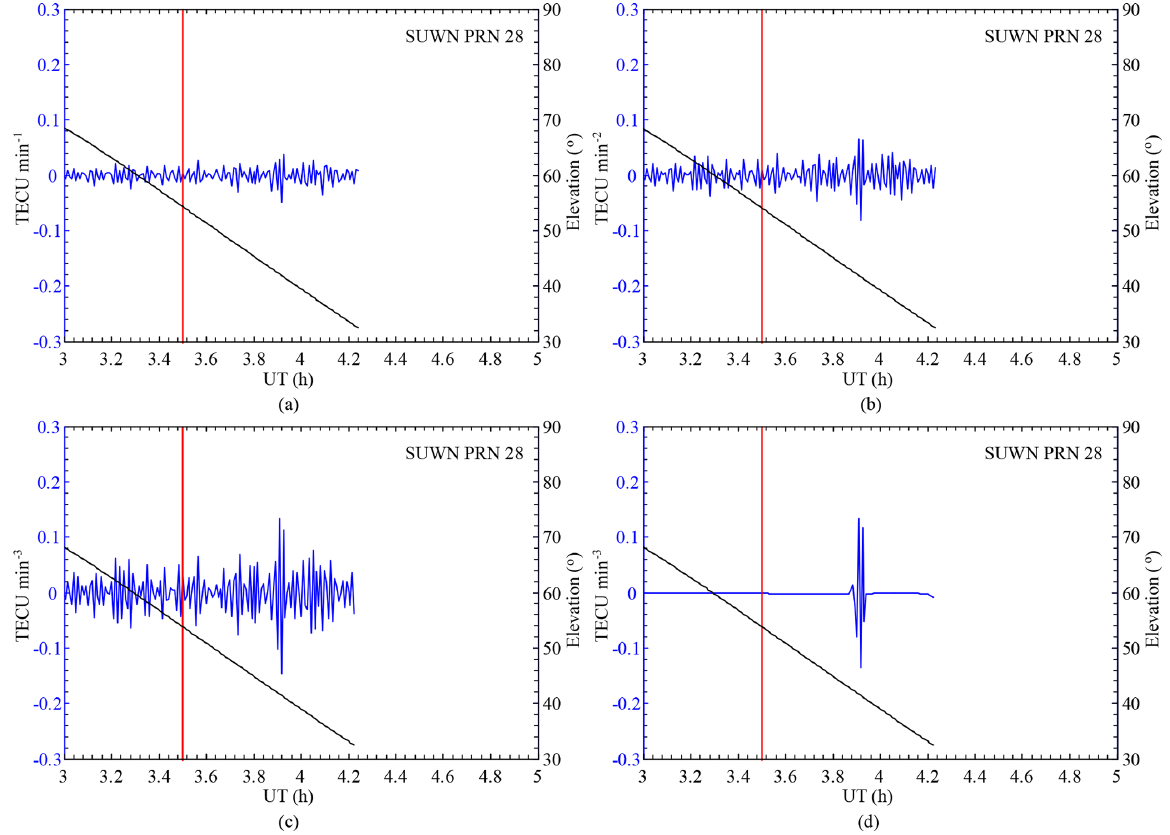
Figure 3. The time sequences of derivatives of relative STEC obtained by the SUWN station using satellite PRN 28 between 03:00 and 05:00UT on 3 September 2017: (a) first-order derivatives, (b) second-order derivatives, (c) third-order derivatives and (d) wavelet de-noised third-order derivatives. The explosion time is represented by the red